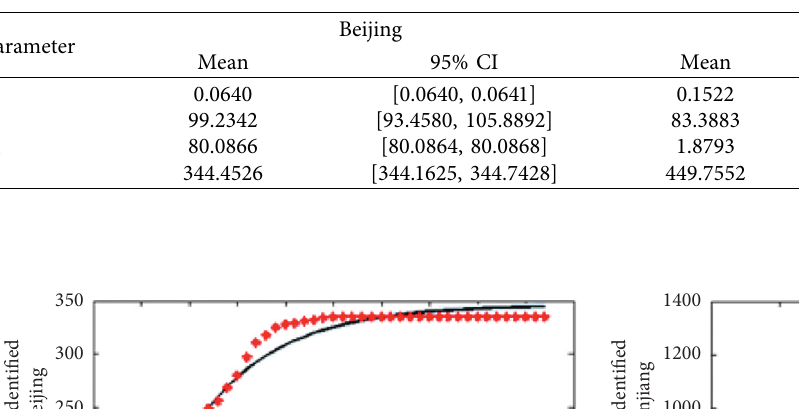
Table 1: Parameter estimation for COVID-19 in Beijing and Xinjiang.